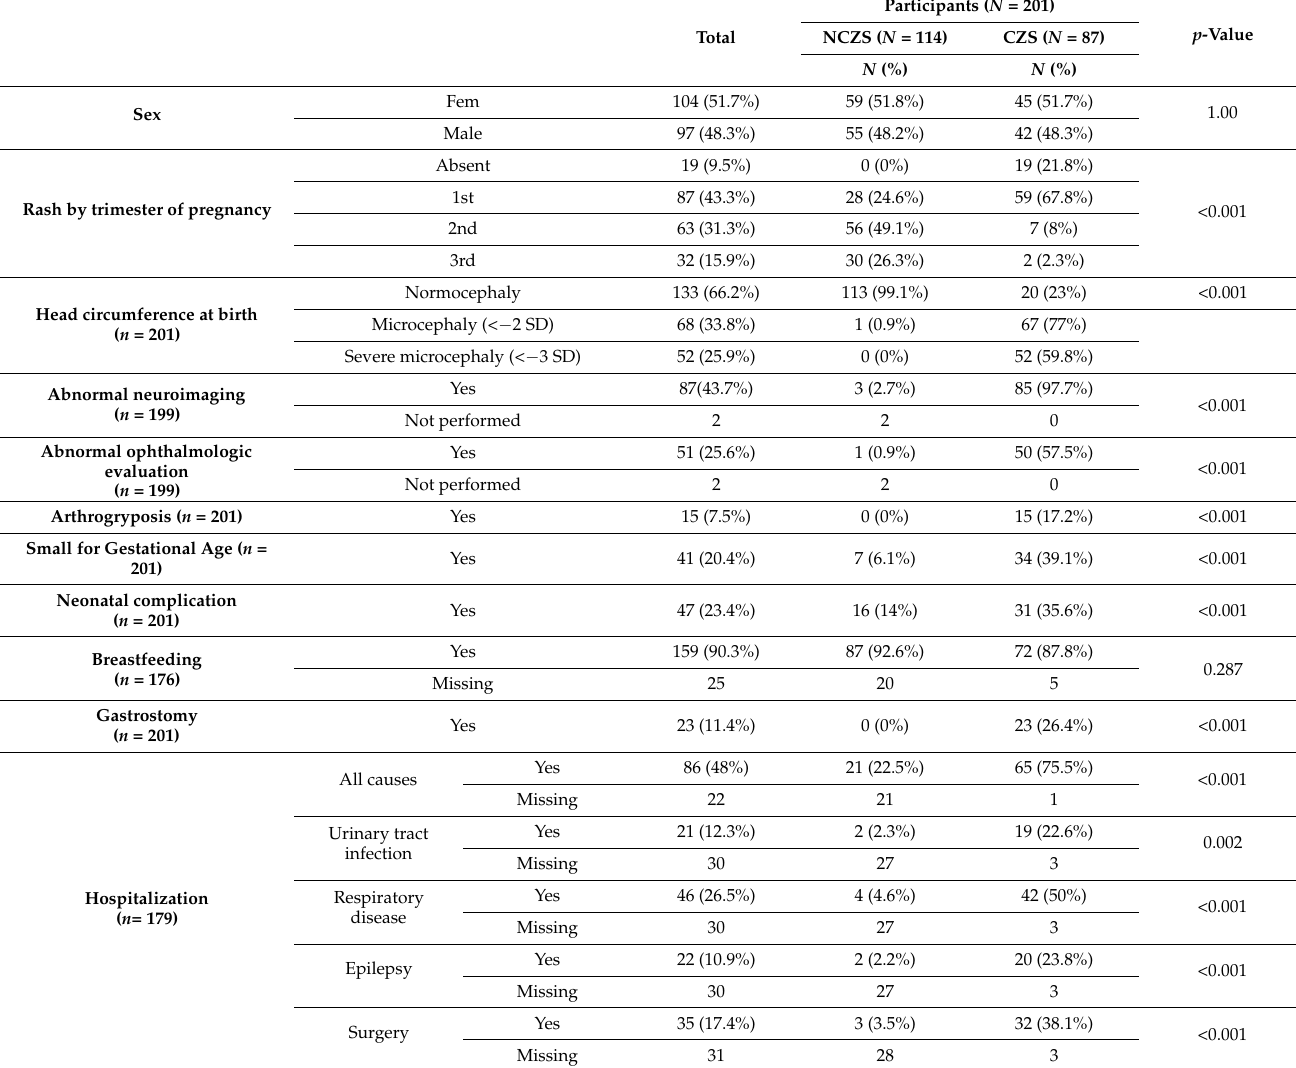
Table 1. Clinical and socioeconomic characteristics and follow-up complications of children with CZS and